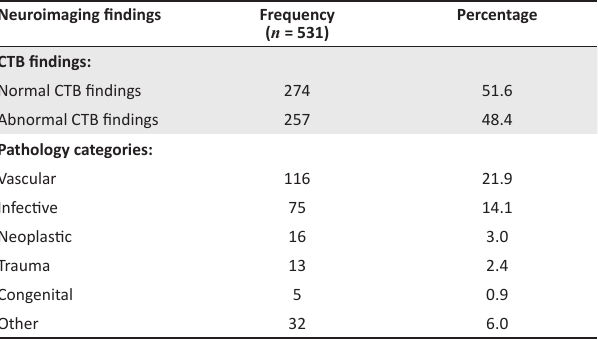
TABLE 2 : Proportions of abnormal CTB findings and cause categories in patients with new-onset seizures. Neuroimaging findings